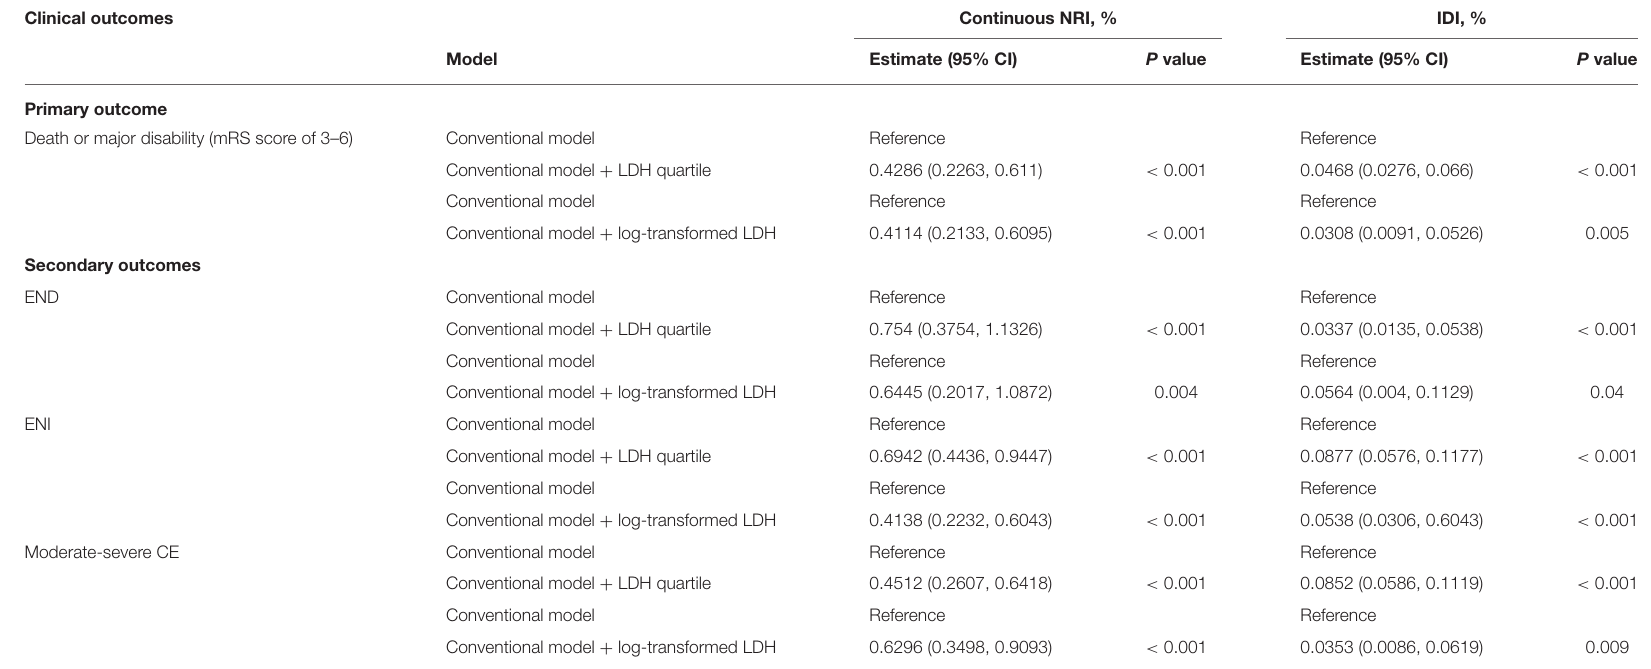
TABLE 3 | Reclassification and discrimination Statistics for clinical outcomes by serum LDH before thrombolysis. Clinical